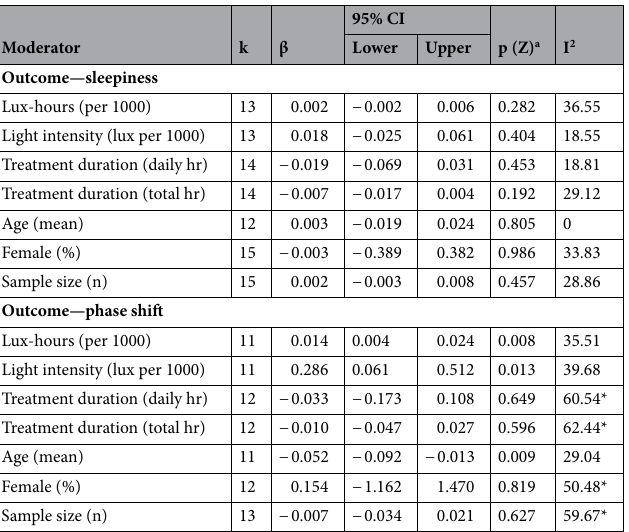
Table 7. Continuous moderators of light treatment effect on sleepiness and phase shift by using metaregression with mixed models. *Significant at p < 0.05. a P value for the Z test of the moderator